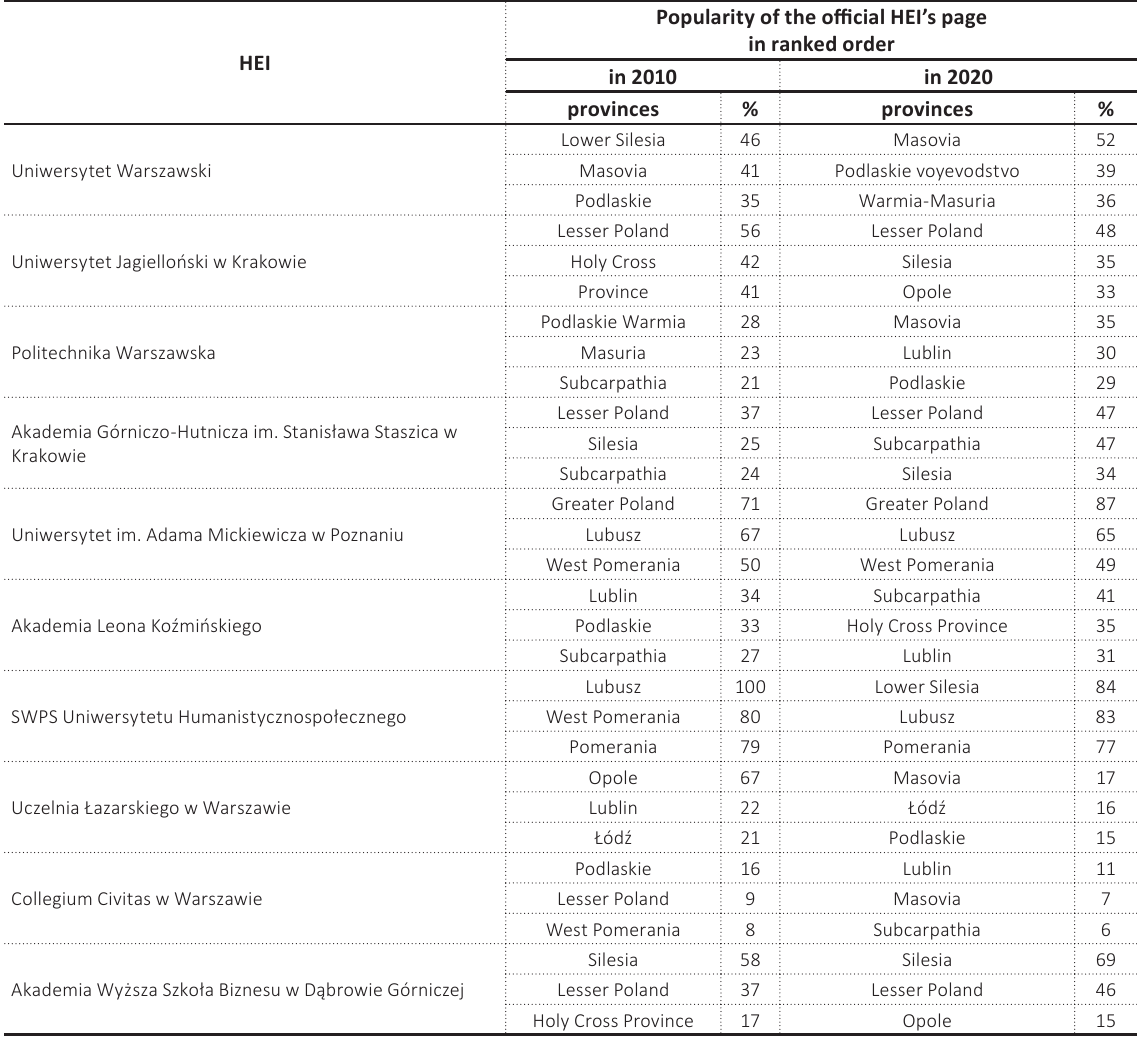
Table 5. Comparison of the number of queries in the Google search system by the official name of HEIs in the provinces in Poland in 2010 and 2020